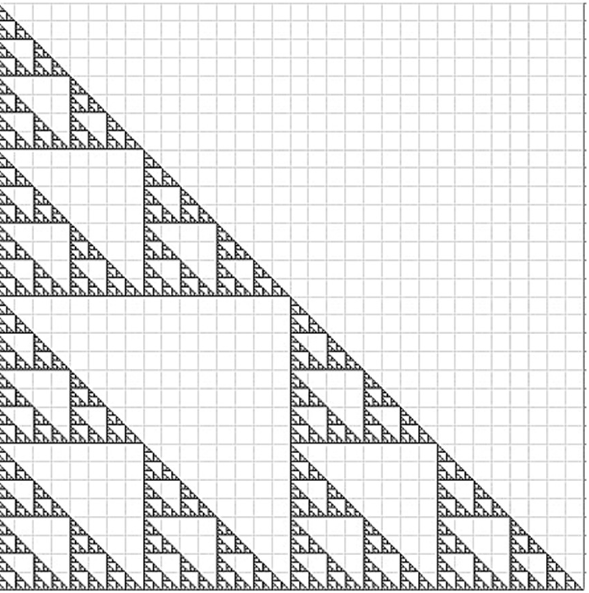
Figure 1. Illustration of Sierpinski Triangle covered by Box-Counting [18] (modified from [18])